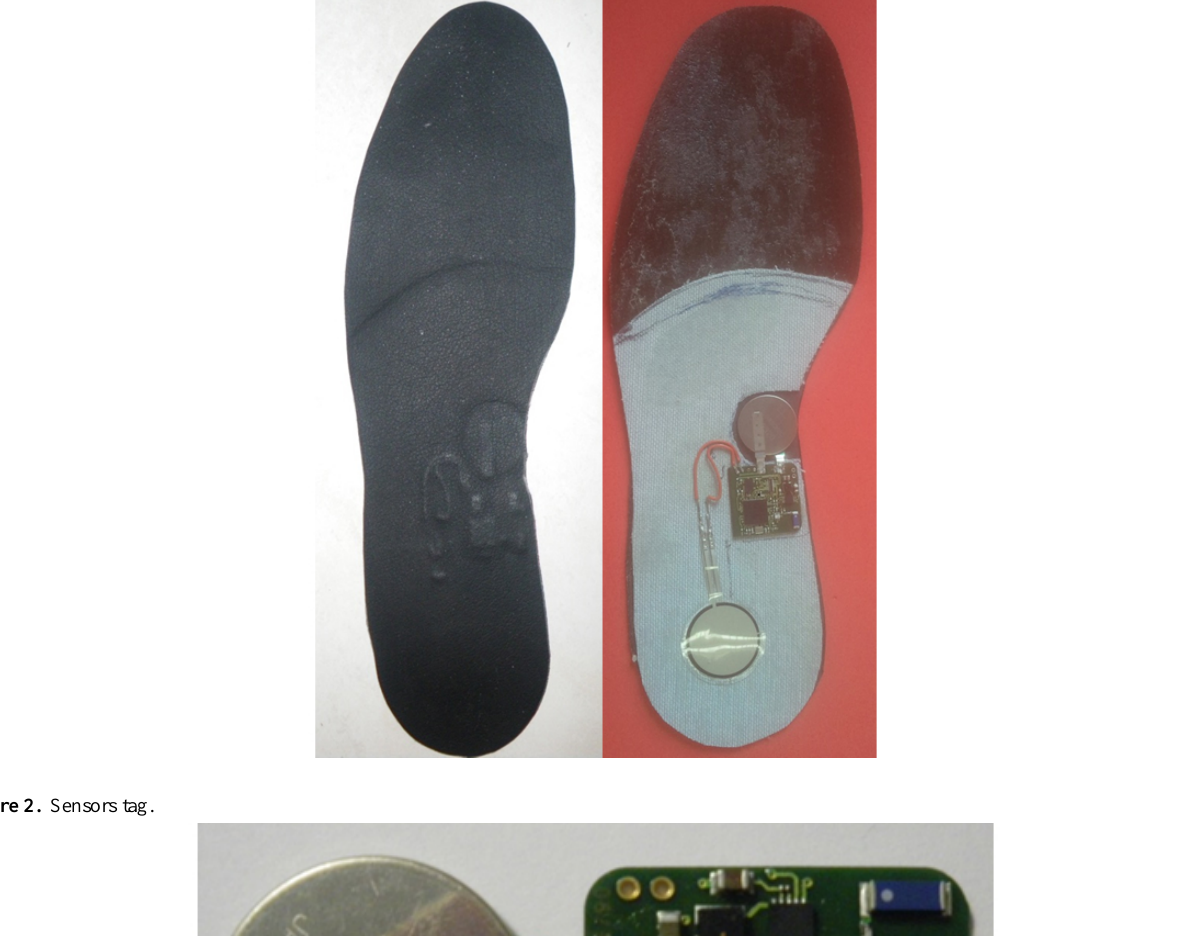
Figure 1. Smart insole.